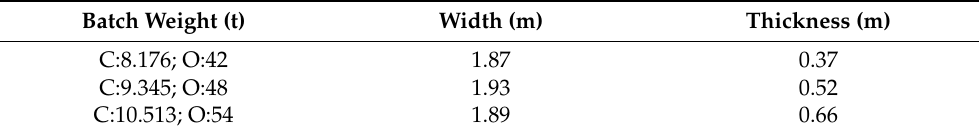
Figure 13. Shape of the ore-free zone with different coke and ore batch weights. Table 10. Width and thickness of the ore-free zone under different coke and ore batch weights.